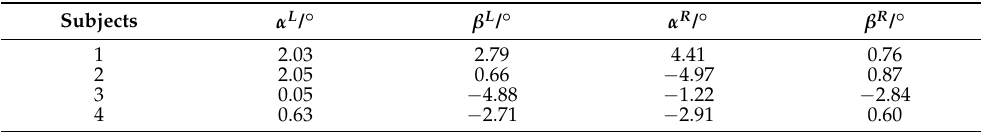
Table 5. Auto-calibrated kappa angles of different subjects.